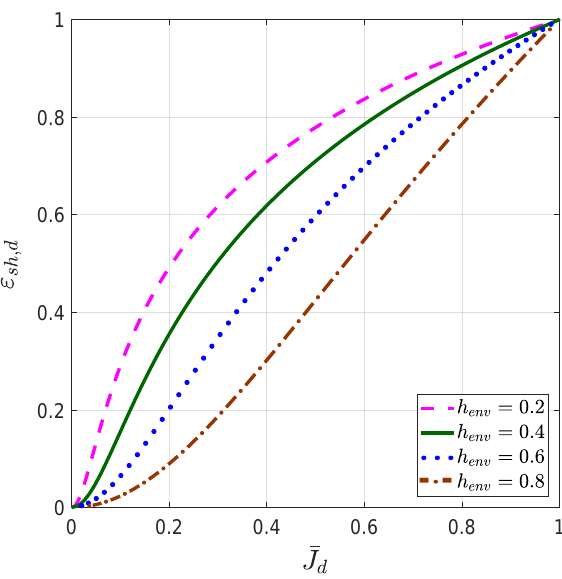
Figure 7. The influence of different levels of ambi- ent relative humidity on the drying creep vs. drying shrinkage kinetics according to the B3 model. The re- maining parameters are from the first line in Tab. 1.